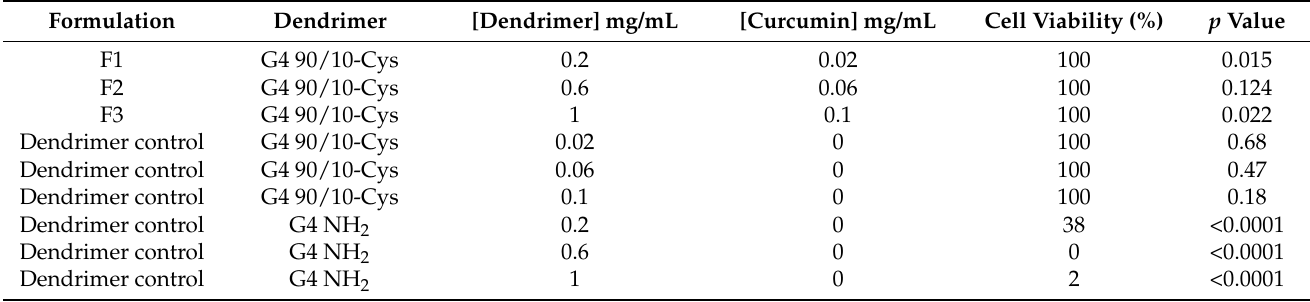
Table 5. Effect of F1, F2 and F3on Rat MSC control cells.